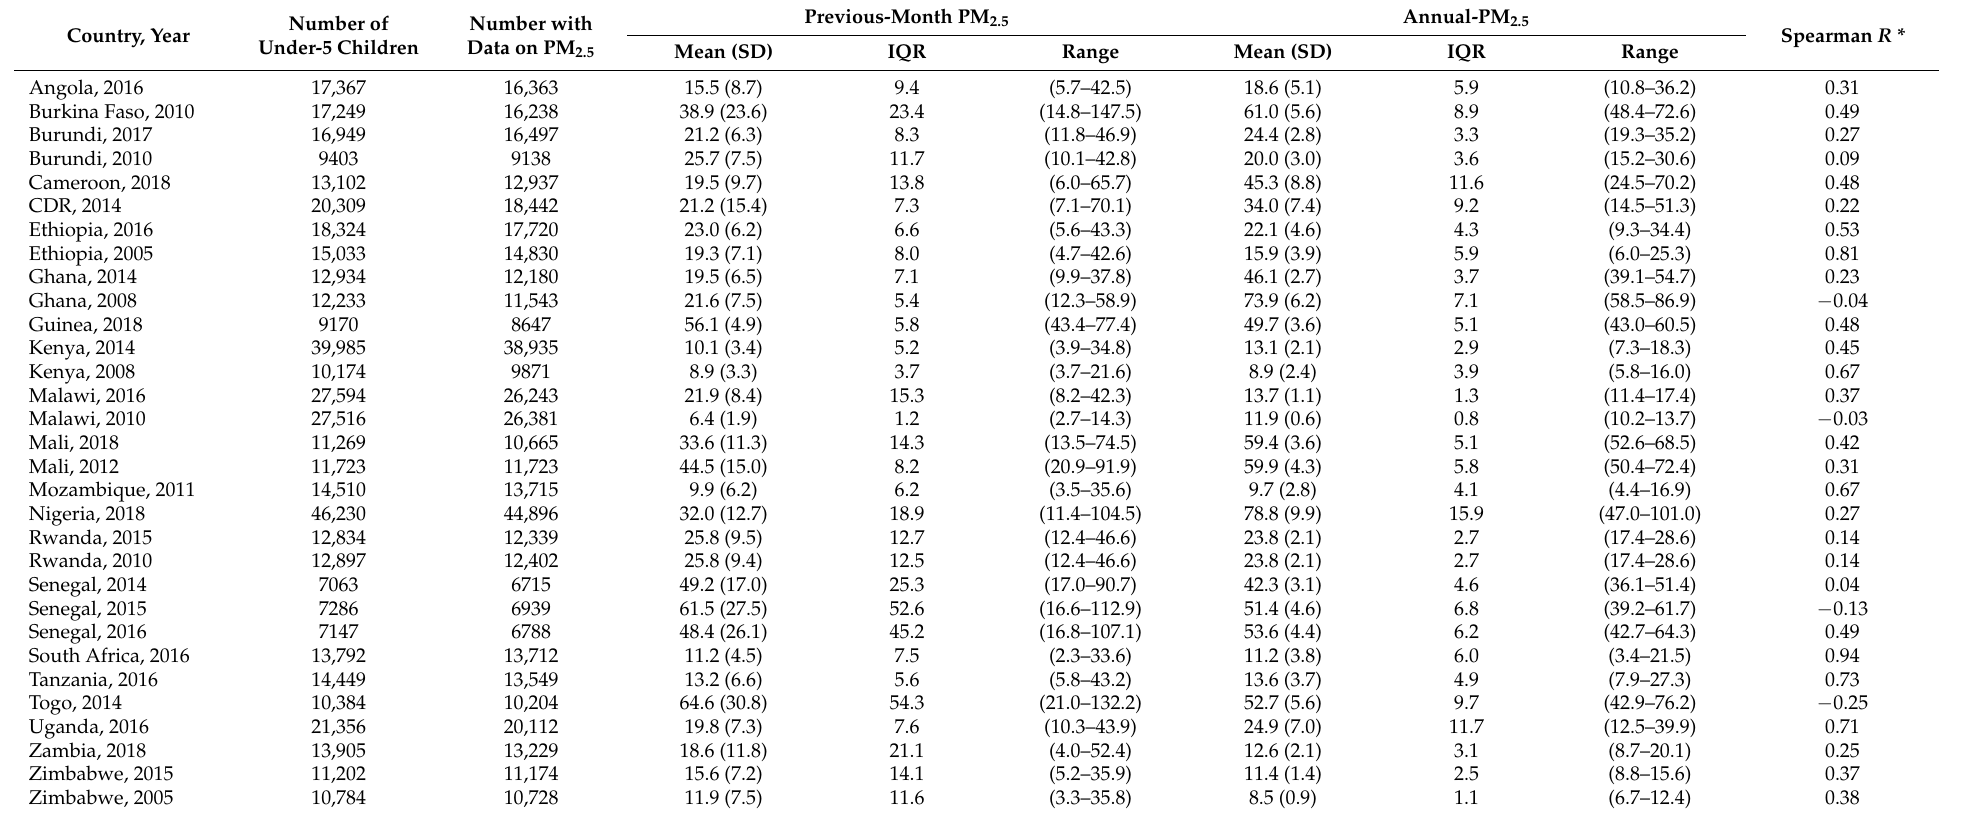
Table 2. Distributions of PM 2.5 concentration ( µ g/m 3 ) across the